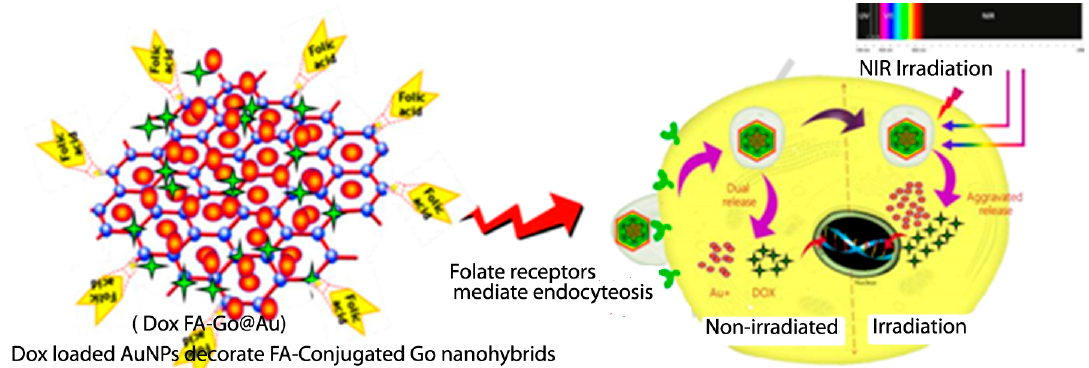
Figure 4. Tumor-localized DOX delivery with simultaneous photothermal ablation [29]. Reproduced with copyright permission from Elsevier, 2017. Legend: FA, folic acid; GO, graphic oxide; AuNPs, gold NPs.